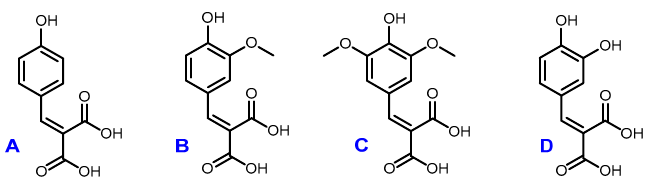
Figure 4. Structures of coumaric diacid ( A ), ferulic diacid ( B ), sinapic diacid ( C ) and caffeic diacid ( D ). Table 5. Conversion rate and isolated yields of p -hydroxycinnamic diacids.